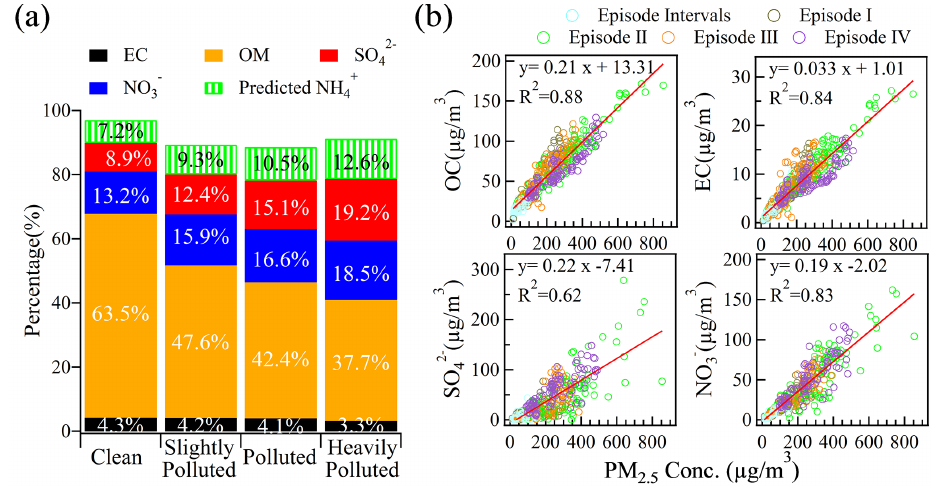
Figure 2. Major composition of PM 2 . 5 with respect to pollution level. (a) Mean percentile composition and (b) hourly concentration of individual species plotted against PM 2 . 5 mass concentration. Values showed in (a) were derived as average of ratios.